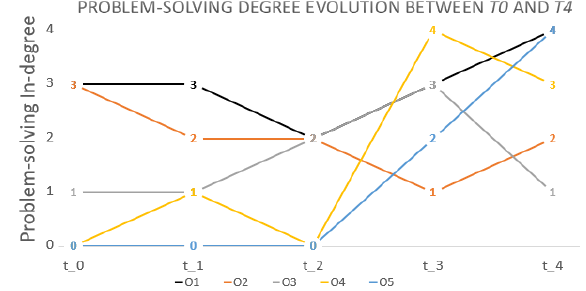
Figure 5. Problem-solving degree evolution between t0 and t4 for project A